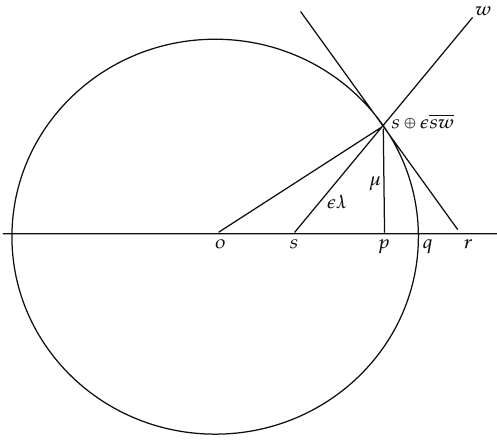
Figure 1: Diagram relating to proof that the function giving the length of a line segment with one endpoint at o has continuous directional derivatives at points other than o , Lemma 2.3. Three facts used in the proof are as follows: (cid:2) 1 (cid:3) Δ { p,o,s ⊕ (cid:4)sw } is similar to Δ { p,s ⊕ (cid:4)sw,r } because ∠ { o,s ⊕ (cid:4)sw,r } is a right angle, (cid:2) 2